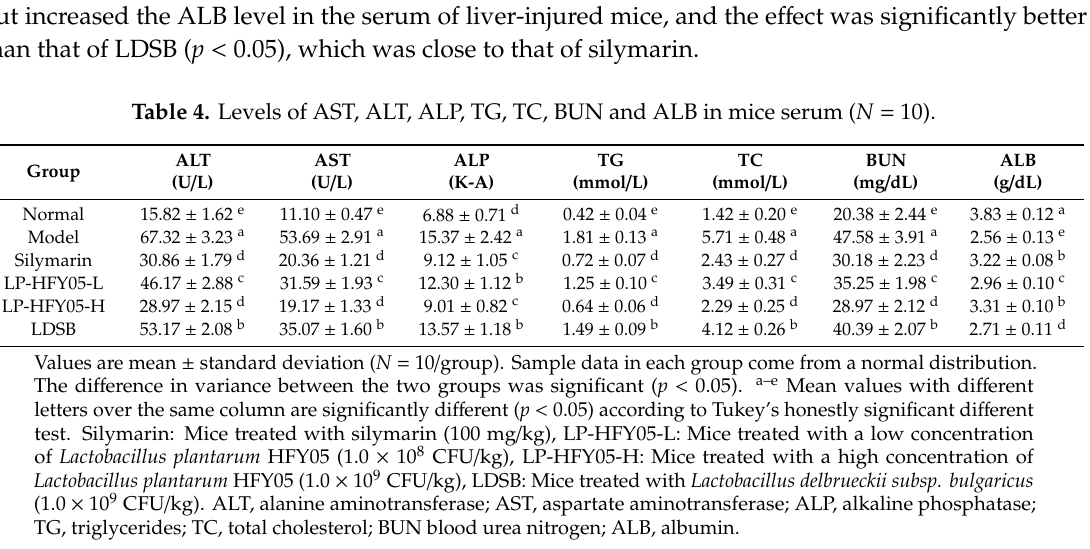
Table 4. Levels of AST, ALT, ALP, TG, TC, BUN and ALB in mice serum ( N = 10).